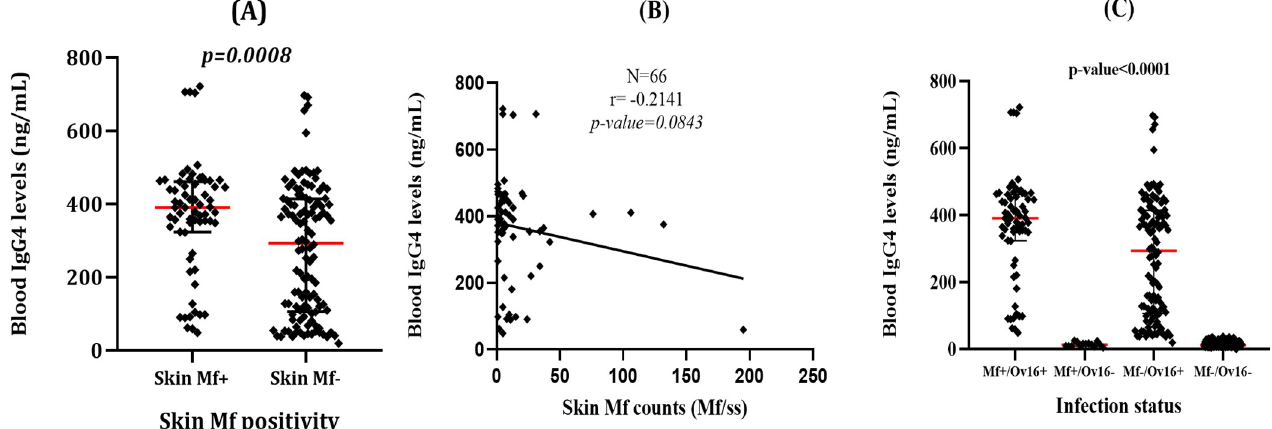
Fig 4. Relationship between skin microfilariae and anti-Ov16 IgG4 levels. (A) Comparison of the anti-Ov16 IgG4 levels between Mf positive and negative individuals; (B) correlation between skin Mf counts and the anti-Ov16 IgG4 levels. IgG4 levels were determined using the normalized OD.